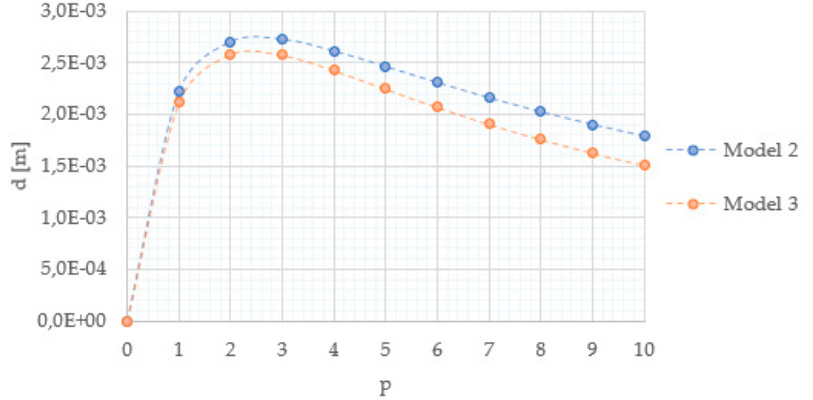
Figure 11. Porosity distribution models M2 and M3: evolution of neutral surface shift.